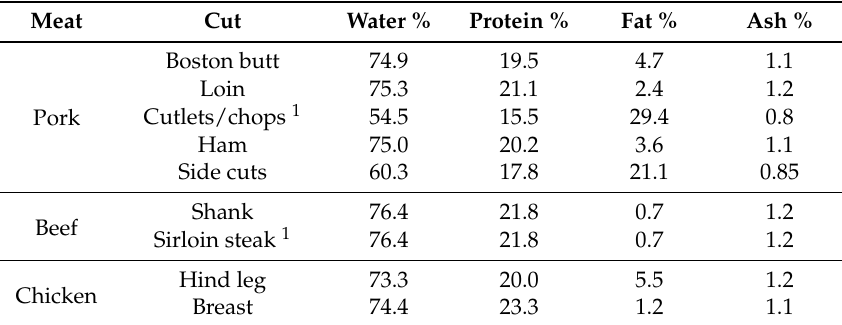
Table 1. Average constituents of common meat